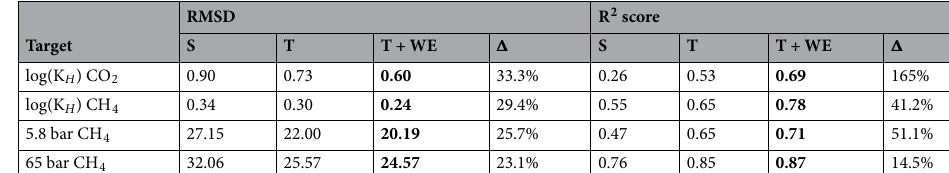
Table 3. Model performance on CoREMOF dataset. Root-mean-square-deviation (RMSD) and coefficient of determination (R 2 score) results in predicting the Henry’s coefficient (log k H ) for CO 2 and CH 4 and gas uptakes for CH 4 for the CoREMOF dataset. Different sets of features (S = baseline structural, T = topological, T + WE = topological and word embeddings) are shown. For each target, the units are mol kg V STP /V respectively. The best model is in bold. As the improvement from the topology + word embeddings is always greater than the structural features, the percentage of improvement (decrease in the case of RMSD and increase in the case of R 2 score) is also shown ( (cid:31) ).